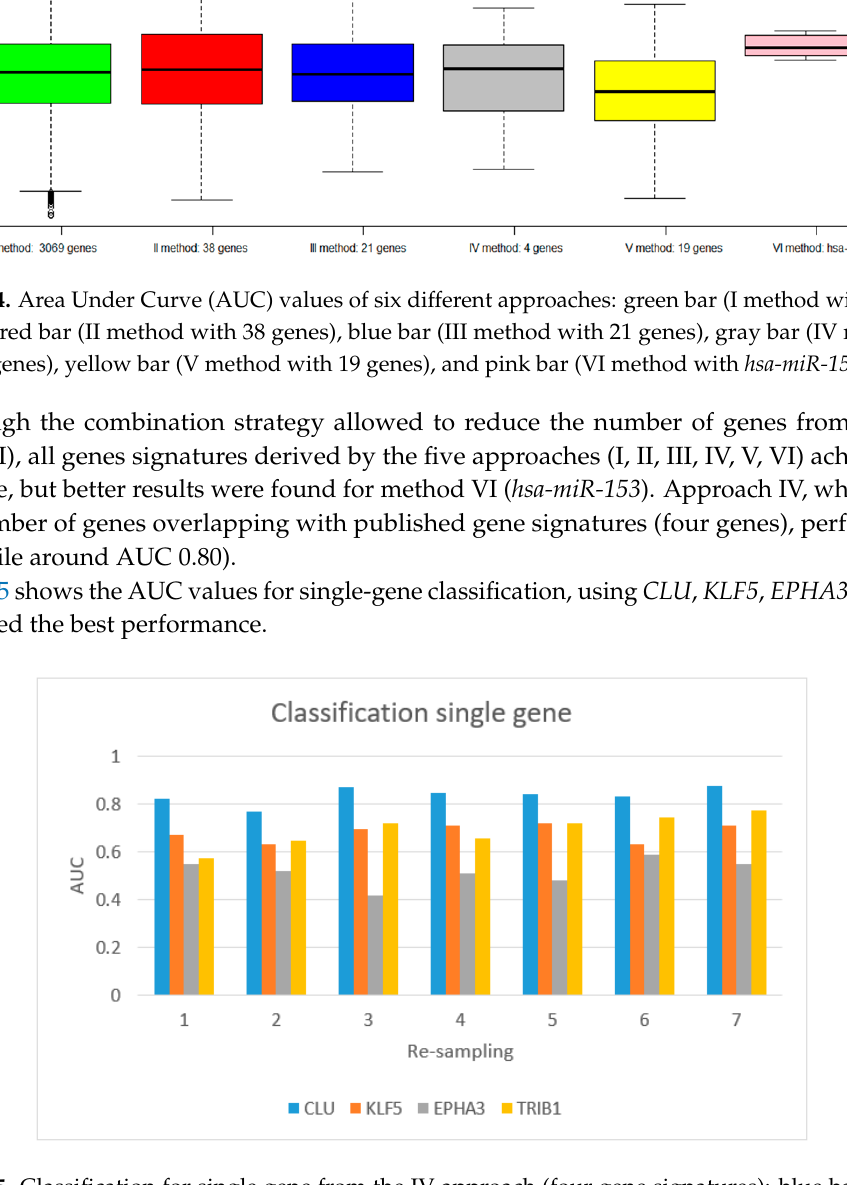
Figure 5. Classification for single gene from the IV approach (four gene signatures): blue bar ( CLU gene), red bar ( KLF5 ), gray bar ( EPHA3 ), and yellow bar ( TRIB1 ).